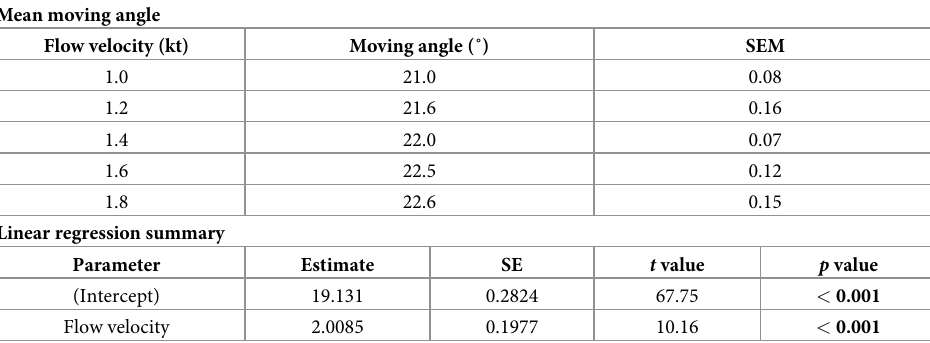
Table 1. The mean moving angle of a shaking codend at each flow velocity and linear regression summary tested in a flume